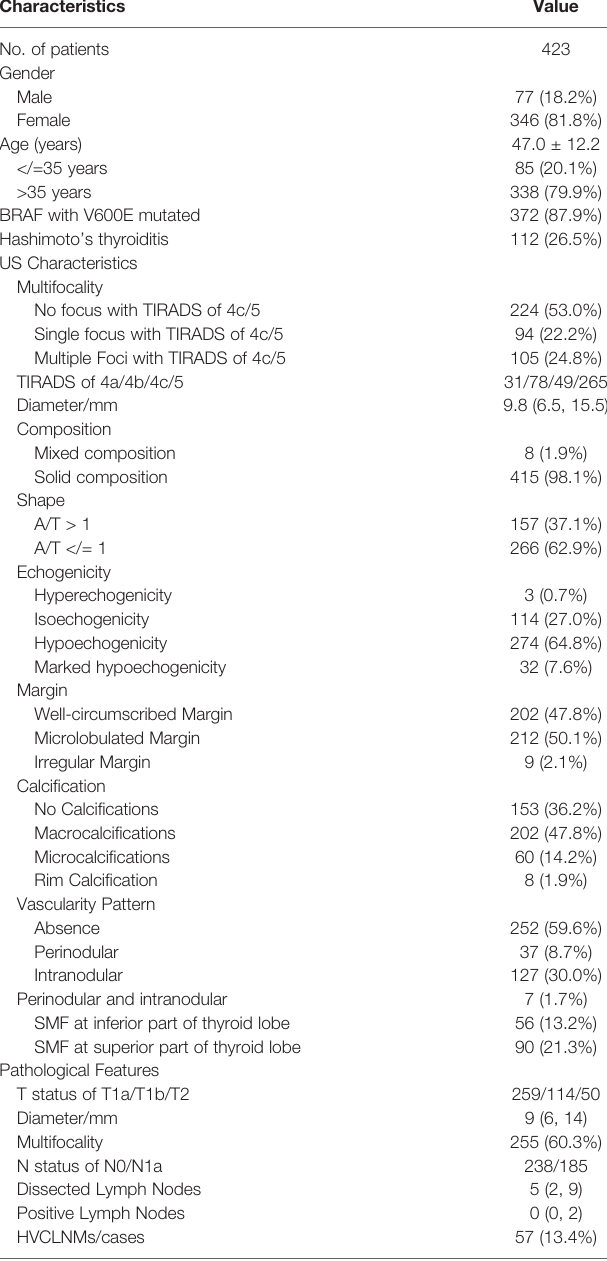
TABLE 1 | Clinicopathological characteristics of the included